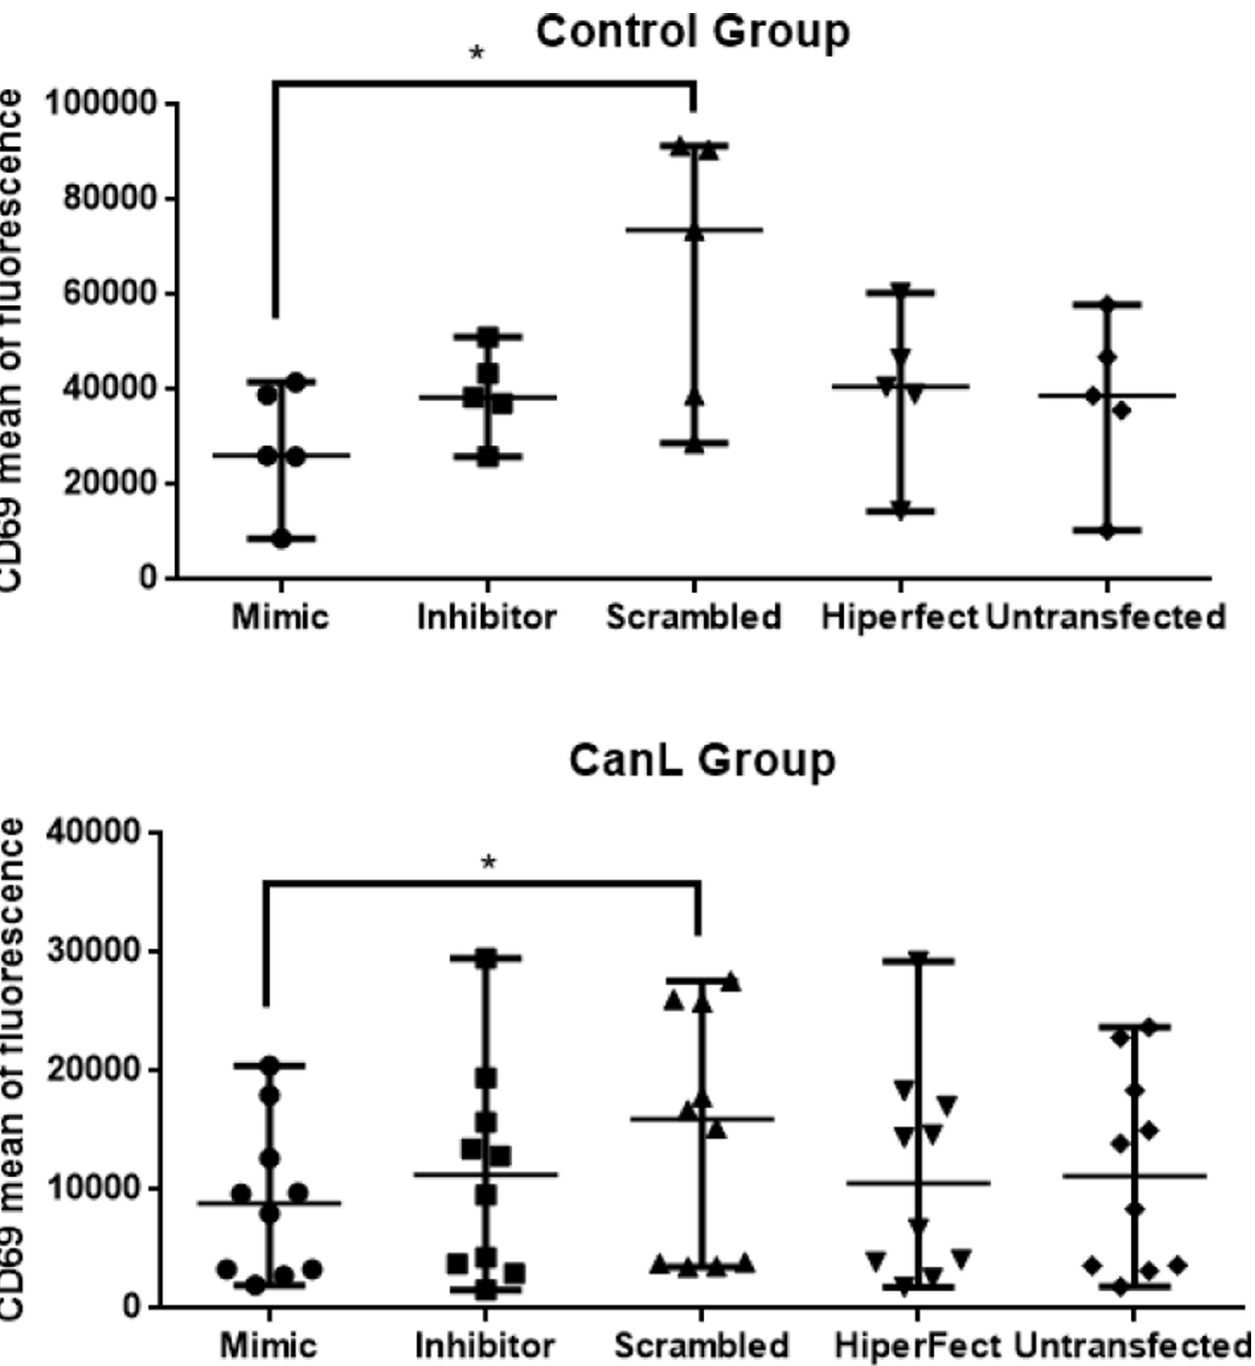
Fig 3. Expression of CD69 after transfection of splenic leukocytes with mimics and inhibitors of miR-21. Expression of CD69 protein in splenic leukocytes of the control (A) and CanL group (B). Splenic leukocytes of dogs naturally infected by L . infantum and healthy dogs were transfected with scrambled, miR-21 mimic, and miR-21 inhibitor, all in the presence of Hiperfect, following 48 h in culture at 37˚C and 5% CO 2 . Data are presented as median ± min-max. The asterisk indicates significant differences (Friedman’s multiple comparison test followed by Dunn’s multiple comparisons test (comparing the mean rank of each treatment with every other treatments), � p <